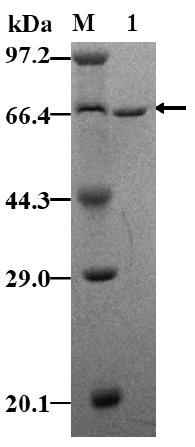
Figure 4. SDS ‐ PAGE analysis of KsLX3 ‐ SIase expressed in B. subtilis and purified using Ni ‐ NTA chromatography. M: protein marker, 1: purified SIase.